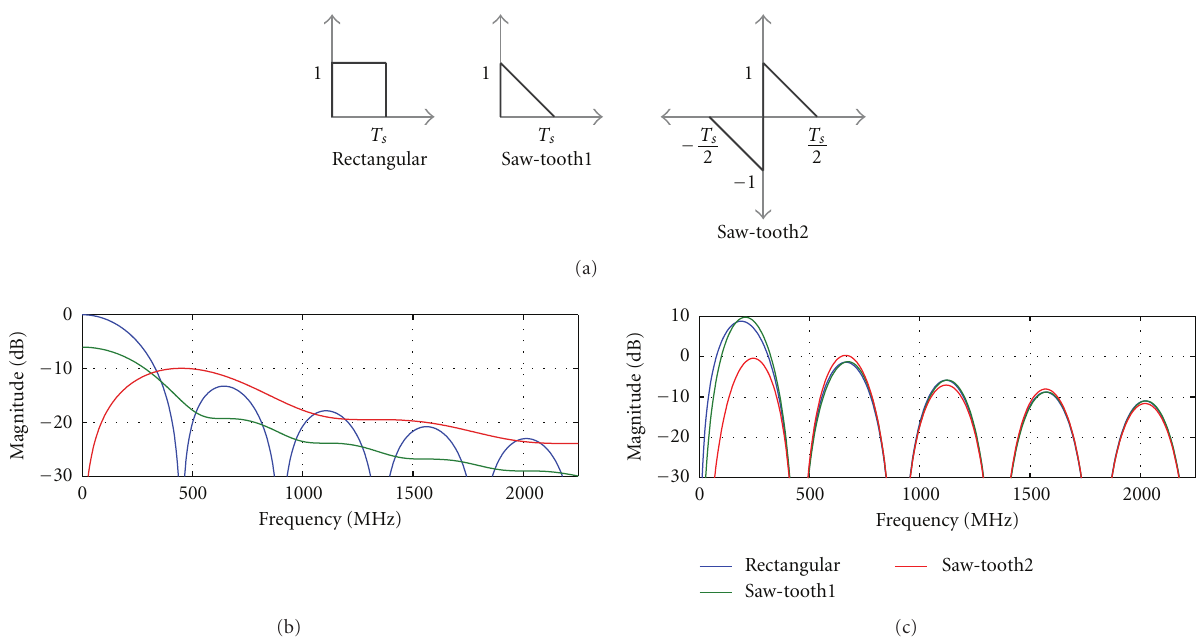
Figure 15: (a) Pulse shapes for rectangular, saw-tooth1, and saw-tooth2 functions. (b) Pulse-shaping function P 1 ( f ) for rectangular, saw- tooth, and modified saw-tooth functions. (c) Calculated transfer function of uncancelled PQN for the three cases ( T s = 1 / 450 MHz).